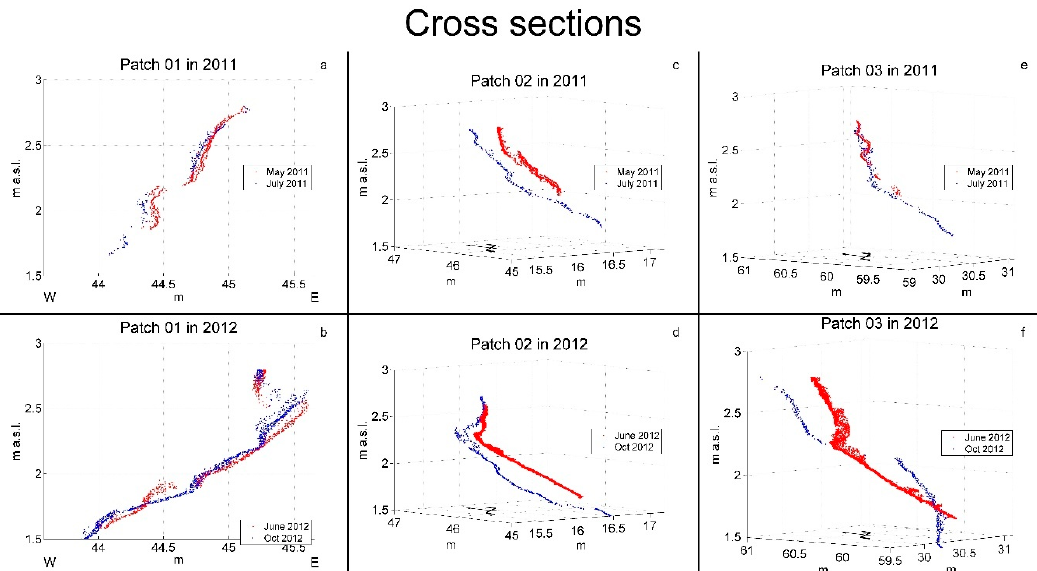
Figure 4. Cross sections of all three patches for the first and second measurement campaigns. Red lines show cross sections in the beginning of a campaign and blue lines show cross sections at the end. Changes for patch 01 are shown in ( a , b ), changes in patch 02 are shown in ( c , d ), and changes in patch 03 are shown in ( e , f ). The first letters ( a , c , e ) represent 2011 and the letters ( b , d , f ) represent 2012.